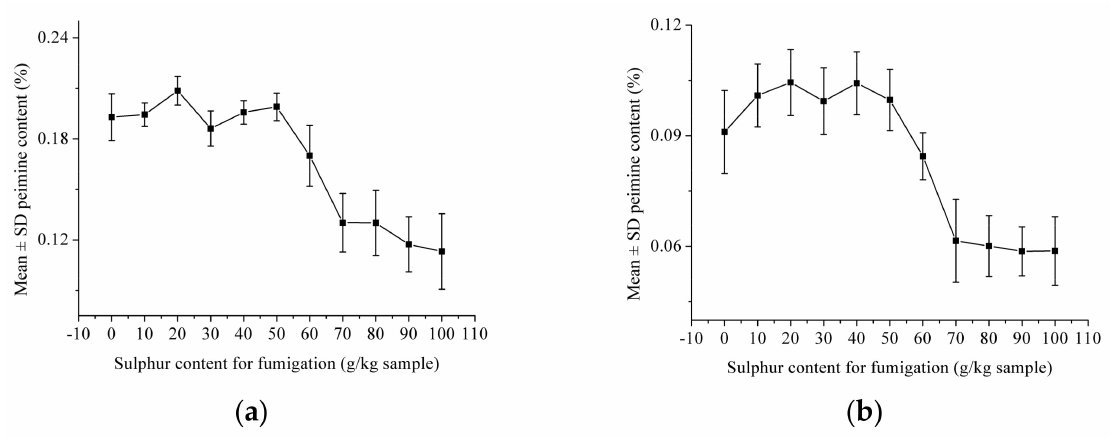
Figure 2. Mean ± standard deviation (SD) for ( a ) peimine and ( b ) peiminine content in Fritillaria thunbergii bulbi under different levels of sulfur fumigation.